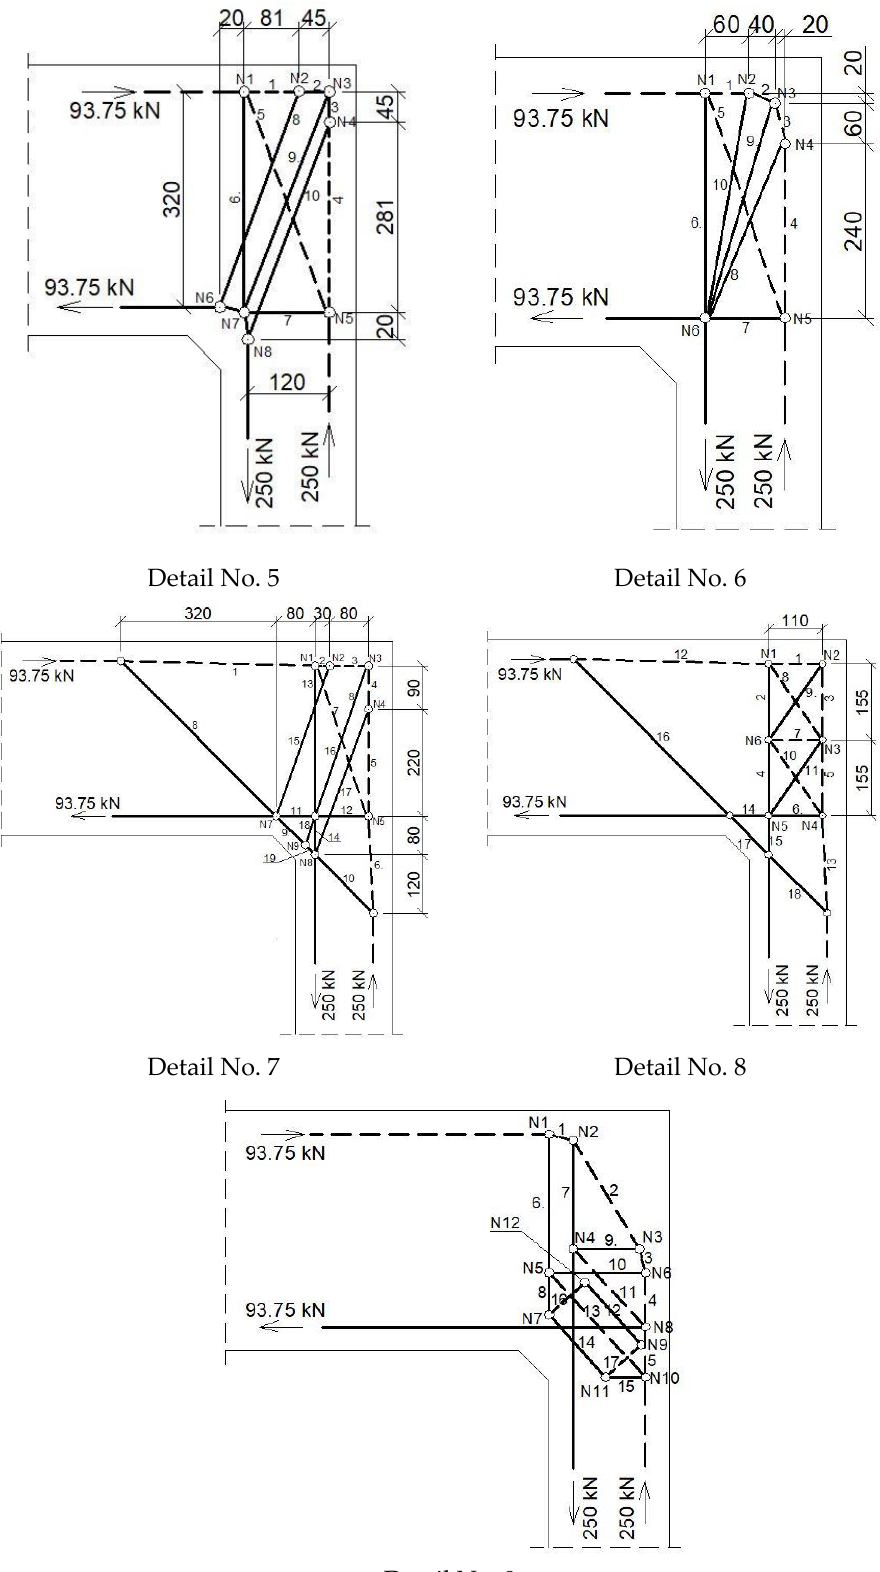
Figure 17. Truss schemes assumed for each reinforcement detail in the S&T method; dimensions in (mm).